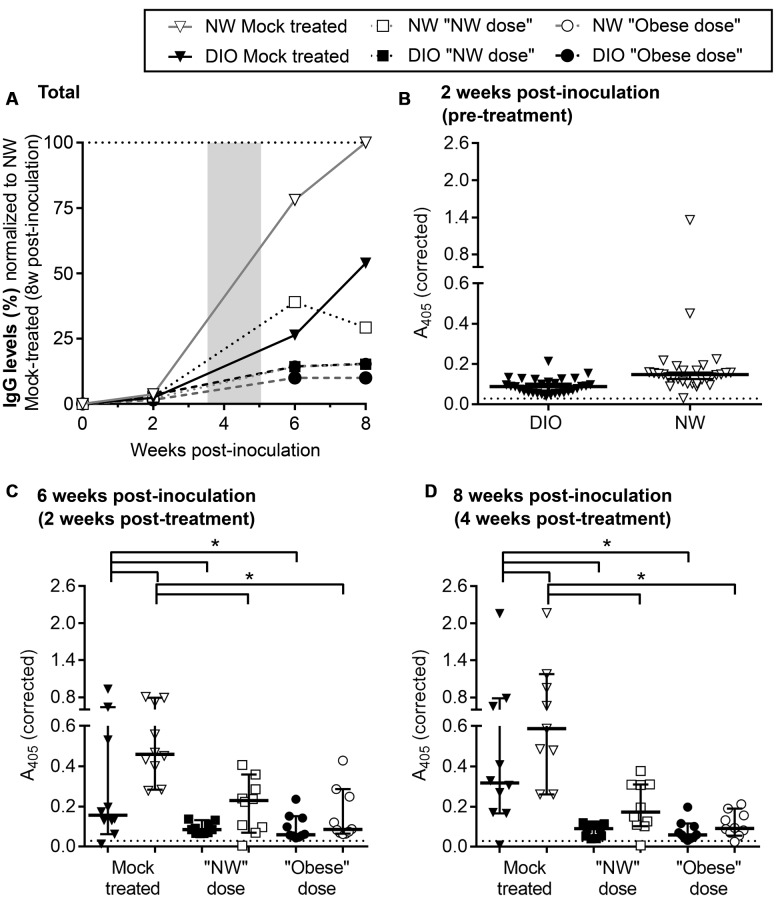
Reduced B. burgdorferi-specific serum IgGs in DIO mice. (A) Development of B. burgdorferi-specific IgG responses in DIO and NW mice during infection and tigecycline treatment. DIO and NW mice are depicted as black and white shapes (with black and gray lines, respectively). Mice from mock-treated groups are represented by triangles. Mice treated with “NW” and “Obese” doses of tigecycline are depicted as squares and circles, respectively. The shaded area represents the period of antibiotic treatment. To facilitate visual comparison among groups and time points, serum dilution-corrected IgG levels were normalized to median IgG levels measured in NW mock-treated mice 8 weeks post-infection (100%; dotted line). Shown are median values in each group. Raw values which were not corrected for serum dilution or normalized to the NW mock 8 week control group are shown in (B–D). Non-normalized A405-corrected absorbance values for IgG ELISAs conducted with sera collected pre-treatment (B: 2 weeks post-inoculation), and at 2 and 4 weeks post-treatment (C,D: 6 and 8 weeks post-inoculation). Serum samples were diluted 1:100 (B) or 1:700 (C,D) and tested against whole cell lysate of B. burgdorferi strain that was used for infection. Shown are individual values, medians with 95% CI. ∗indicates p < 0.05 (two-way ANOVA with Holm-Sidak post-tests). Pre-immune sera from individual mice were used as a negative control at 1:100 dilution (dotted lines in B–D). There was no difference between pre-immune (non-specific) IgG levels of DIO and NW mice (p > 0.05; as determined by unpaired parametric t-test).